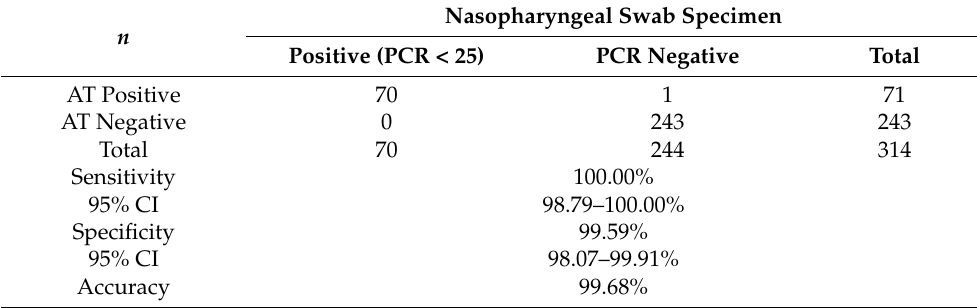
Table 1. Test results and analysis of nasopharyngeal swab specimens with Ct values of PCR positivity less than